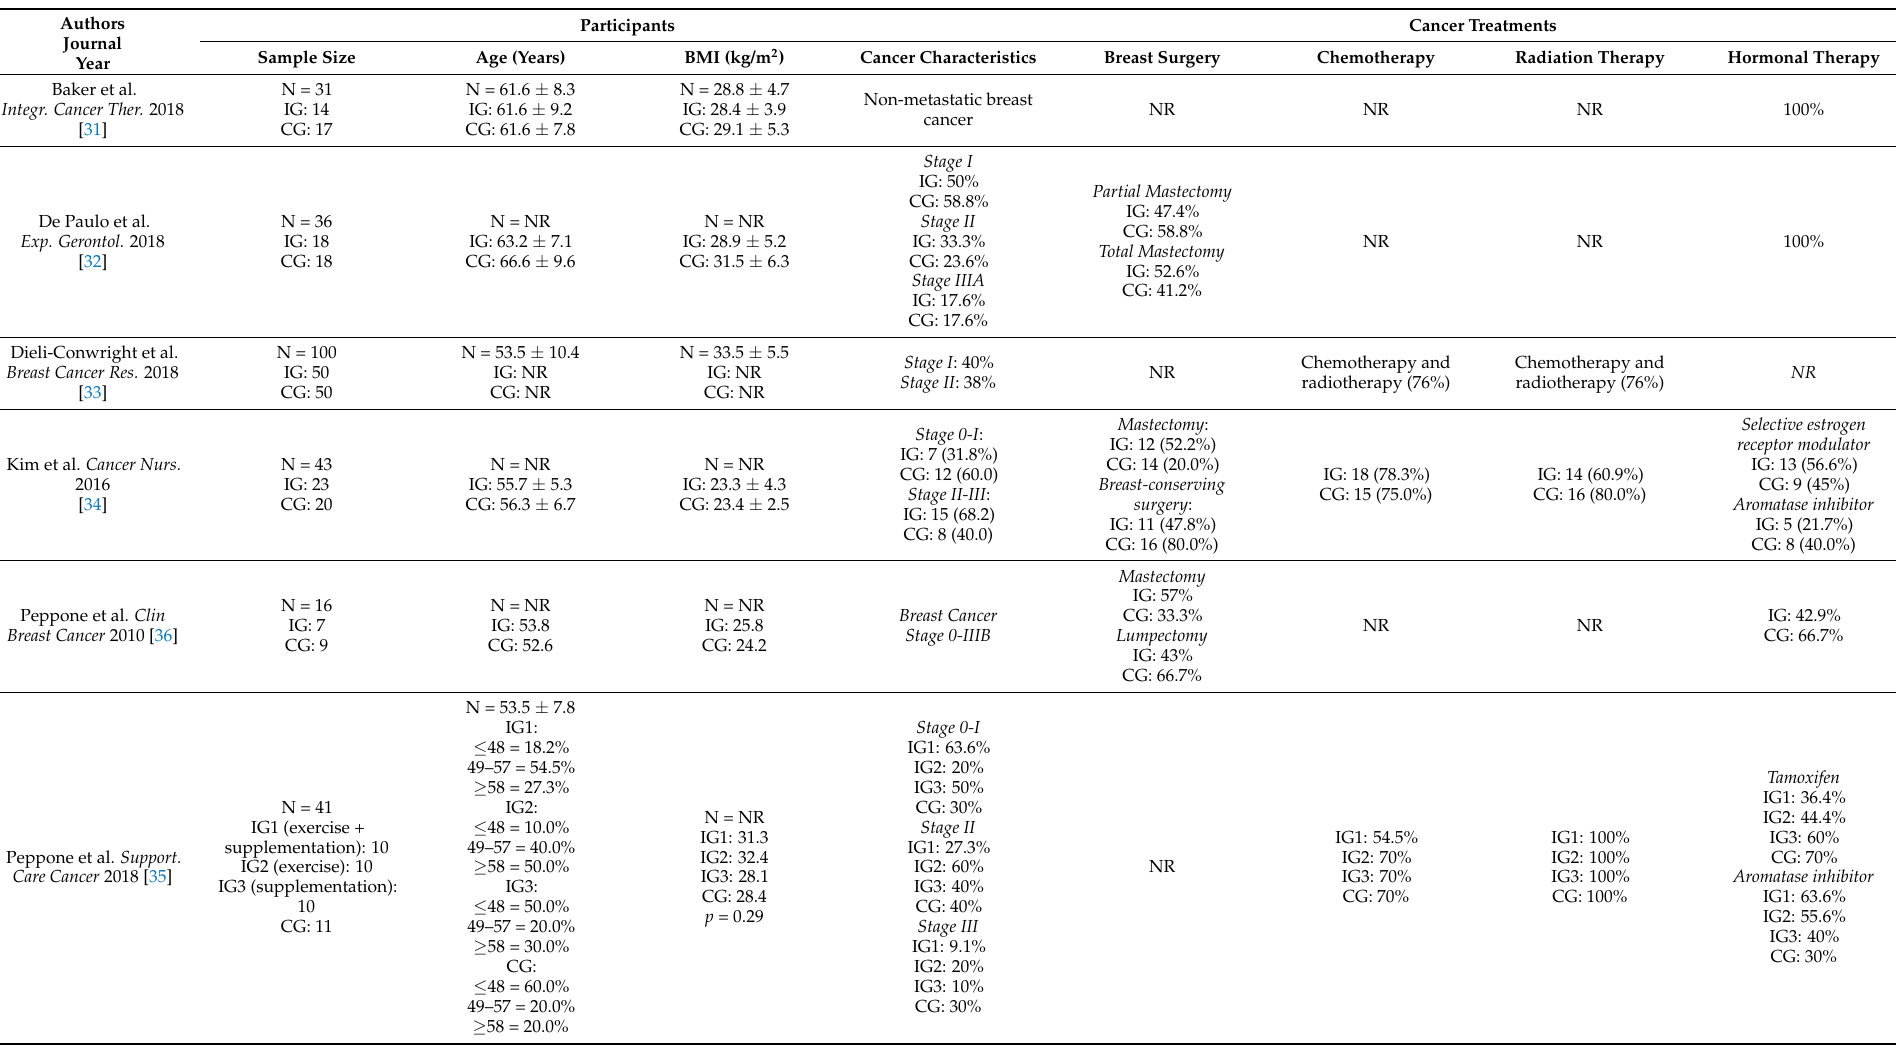
Table 2. Main characteristics of the study